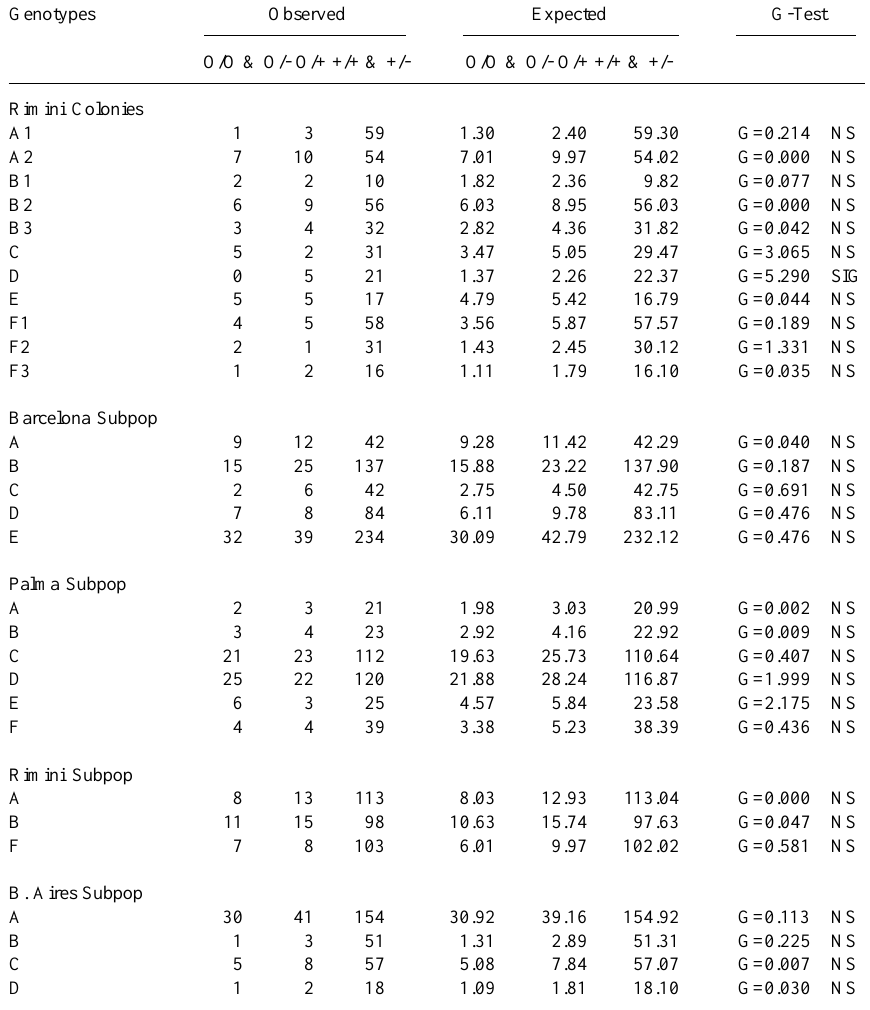
Table II - Hardy-Weinberg analysis of O (orange) locus assuming a sex-ratio 1:1 with G-test (Sokal and Rohlf, 1981). This analysis is only shown for Rimini cat colonies and Barcelona, Palma Majorca, Rimini and Buenos Aires cat subpopulations. The Hardy-Weinberg analysis results for Barcelona, Palma Majorca and Buenos Aires cat colonies can be found elsewhere and were also in Hardy-Weinberg equilibrium. O/O & O/- = Orange animals; +/+ & +/- = non-orange animals; O/+ = heterozygote females; NS = nonsignifi- cant; SIG = P < 0.05.